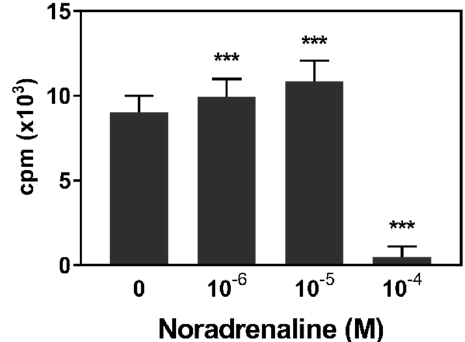
Figure 2. Lymphocyte proliferation after incubation with noradrenaline (10 − 6 –10 − 4 M) and the mitogen pokeweed mitogen in vitro ( n = 12). Data are presented as lsmeans + SEM of cpm (counts per minute) of the untransformed data. Asterisks indicate significant di ff erences between treatment and hormone-free control (0): *** p < 0.001